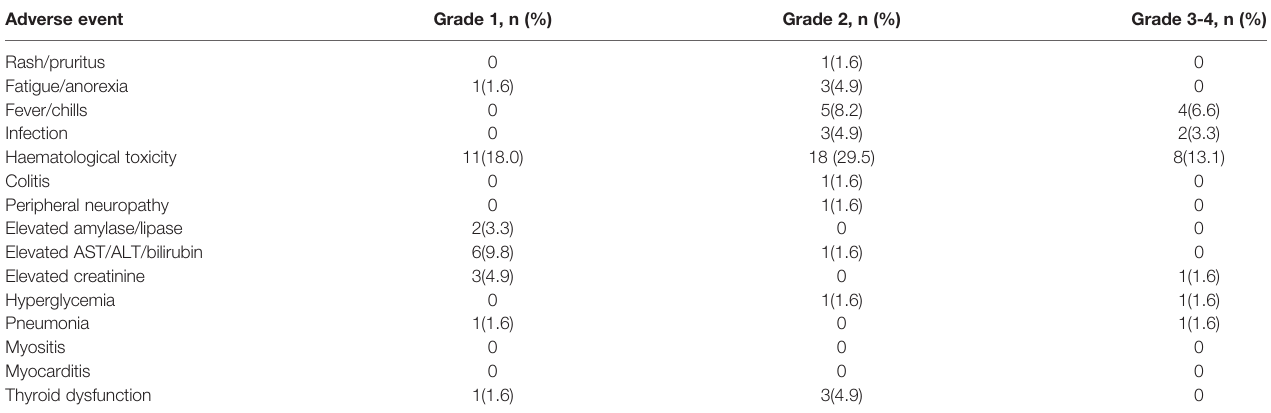
TABLE 3 | Treatment-related adverse events classi fi ed by